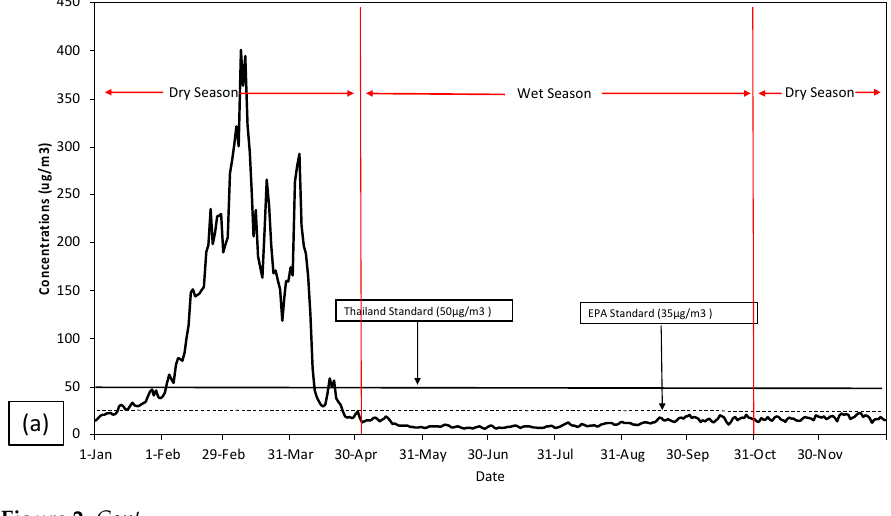
Figure 2. ( a ) Daily and ( b ) monthly means of the PM 2.5 concentrations in northern Thailand during 2020–2029.